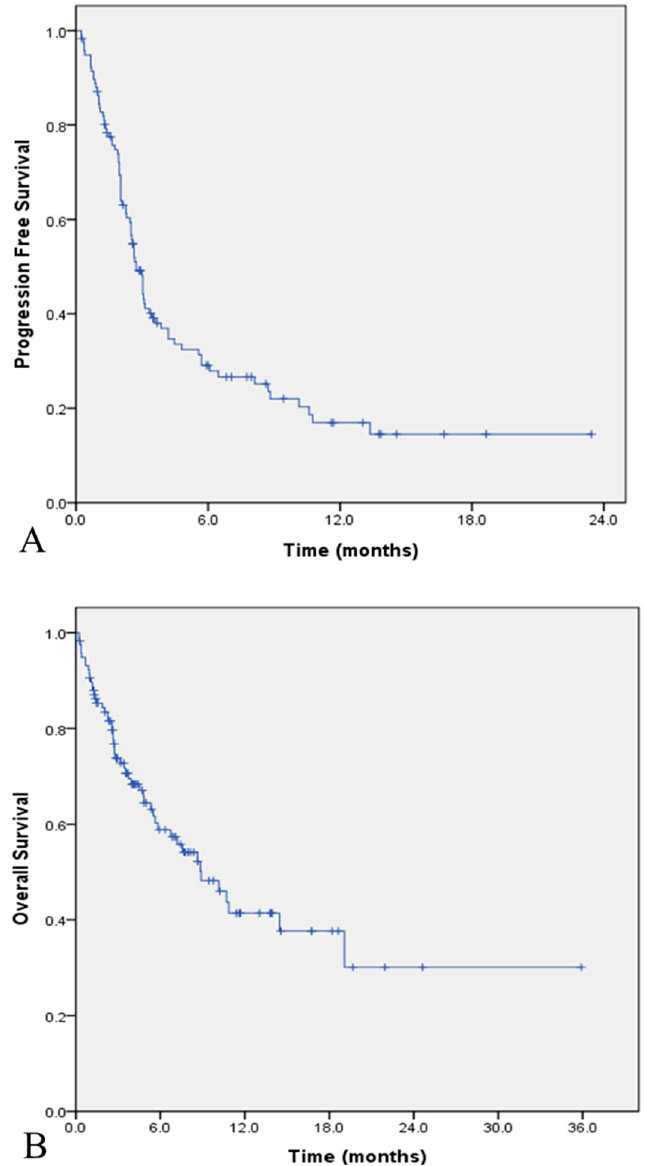
Figure3. Kaplan–Meierestimatesofsurvivalinthetotalstudypopulation( n = 117). ( A )Progression-free survival; ( B ) overall